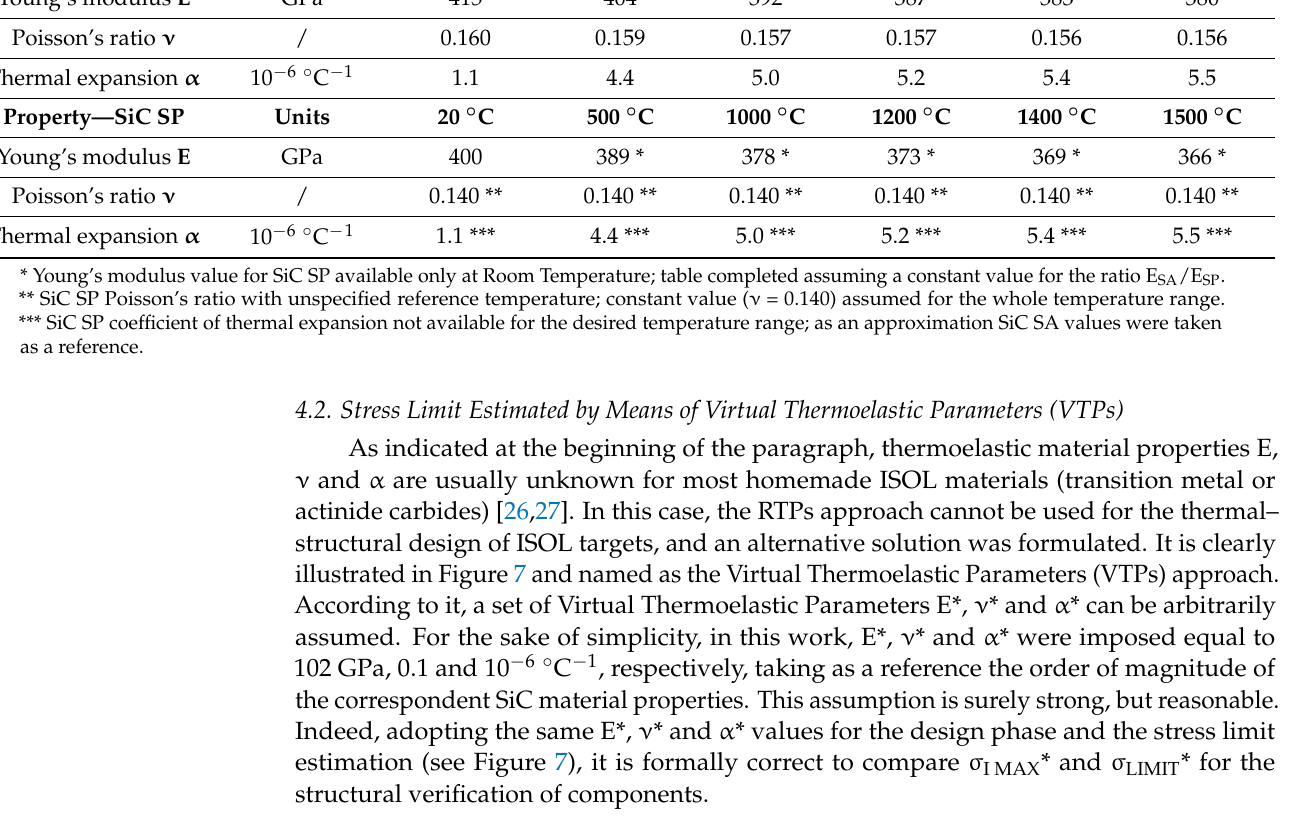
Table 1. Real Thermoelastic Parameters (RTPs) for the Hexoloy ® silicon carbides SA [19] and SP [25]. Property—SiC